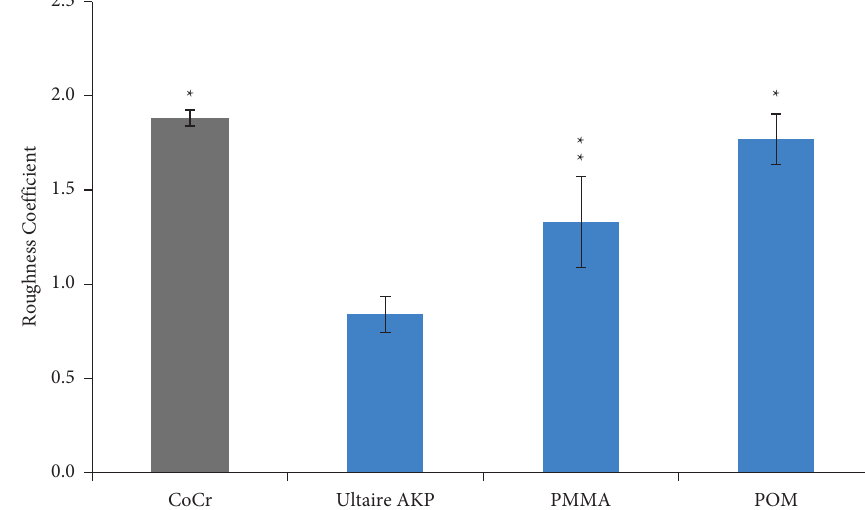
Figure 4: Roughness coefficients of Streptococcus spp. biofilms (average ± SE) grown on Ultaire ® AKP and traditional dental materials for 24 hours under dynamic conditions in the CDC Biofilm Reactor. Gray bar is the highest biofilm roughness coefficient. ∗ p ≤ 0 . 01 vs Ultaire ® AKP; ∗∗ p � 0 . 02 vs Ultaire ®